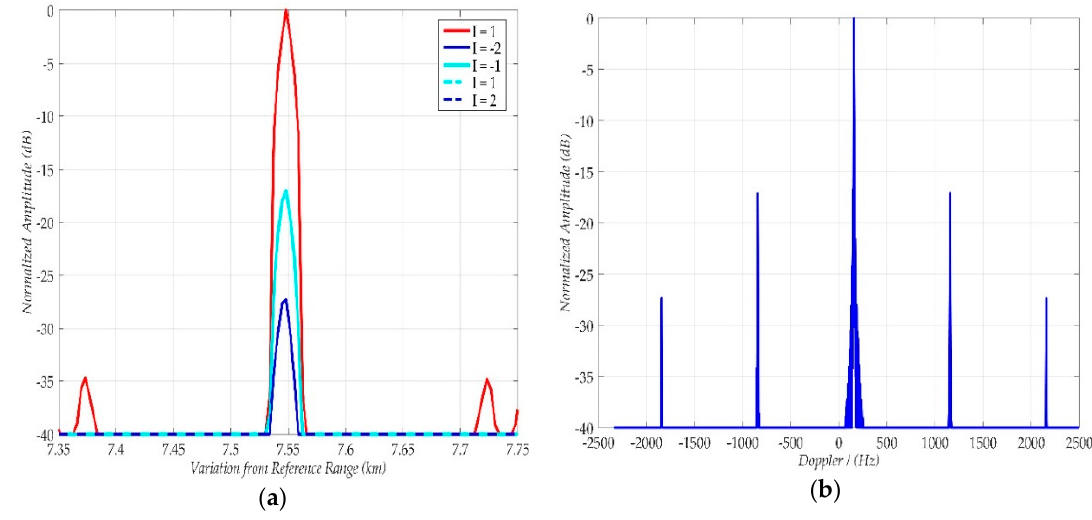
Figure 10. The range and Doppler profile when the Doppler ambiguity exists. ( a ) Range profile ( b ) Doppler profile.